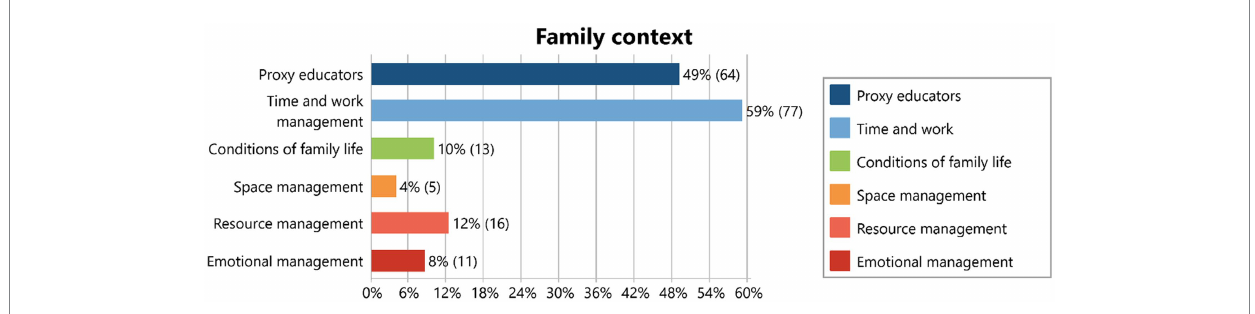
FIGURE 2 Frequency of documents referring to the subcategory Family context, within the category Parents’